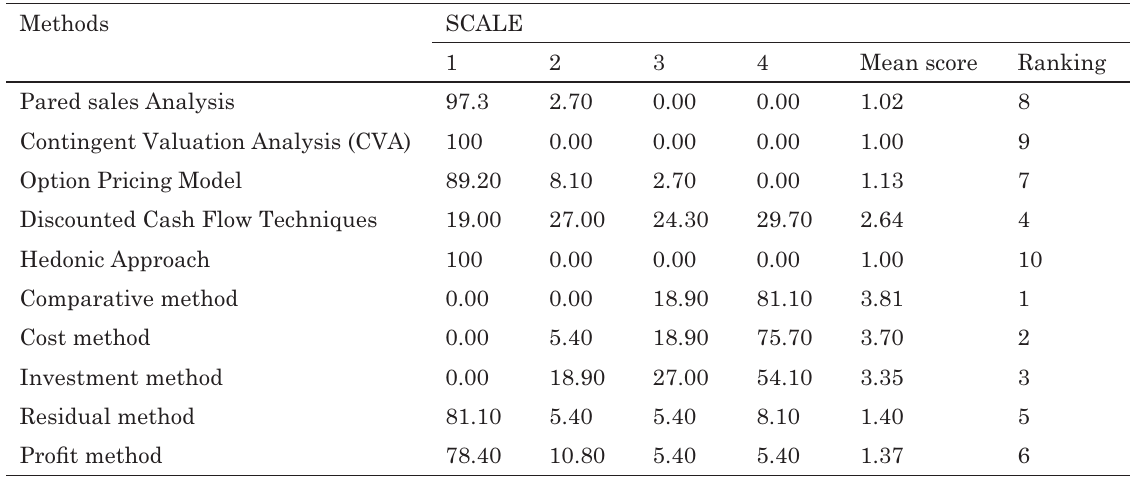
Table 4. Methods used in the valuation of properties that are contaminated by waste dump sites Methods